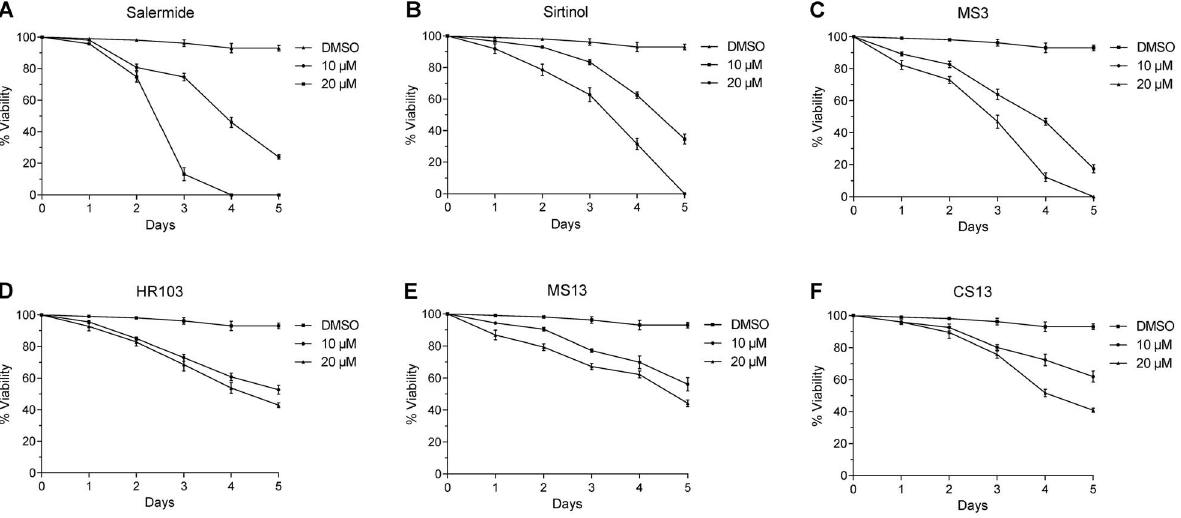
Figure 4. Viability of schistosomula maintained in culture up to 5 days in the presence or absence of 10 m M or 20 m M Salermide (Figure 4A), Sirtinol (Figure 4B), MS3 (Figure 4C), HR103 (Figure 4D), MS13 (Figure 4E) and CS13 (Figure 4F). Dead and dying larvae are dark and opaque and present granular aspect and tegumental damage. Results are expressed as mean % surviving larvae ( 6 SEM, three independent experiments).